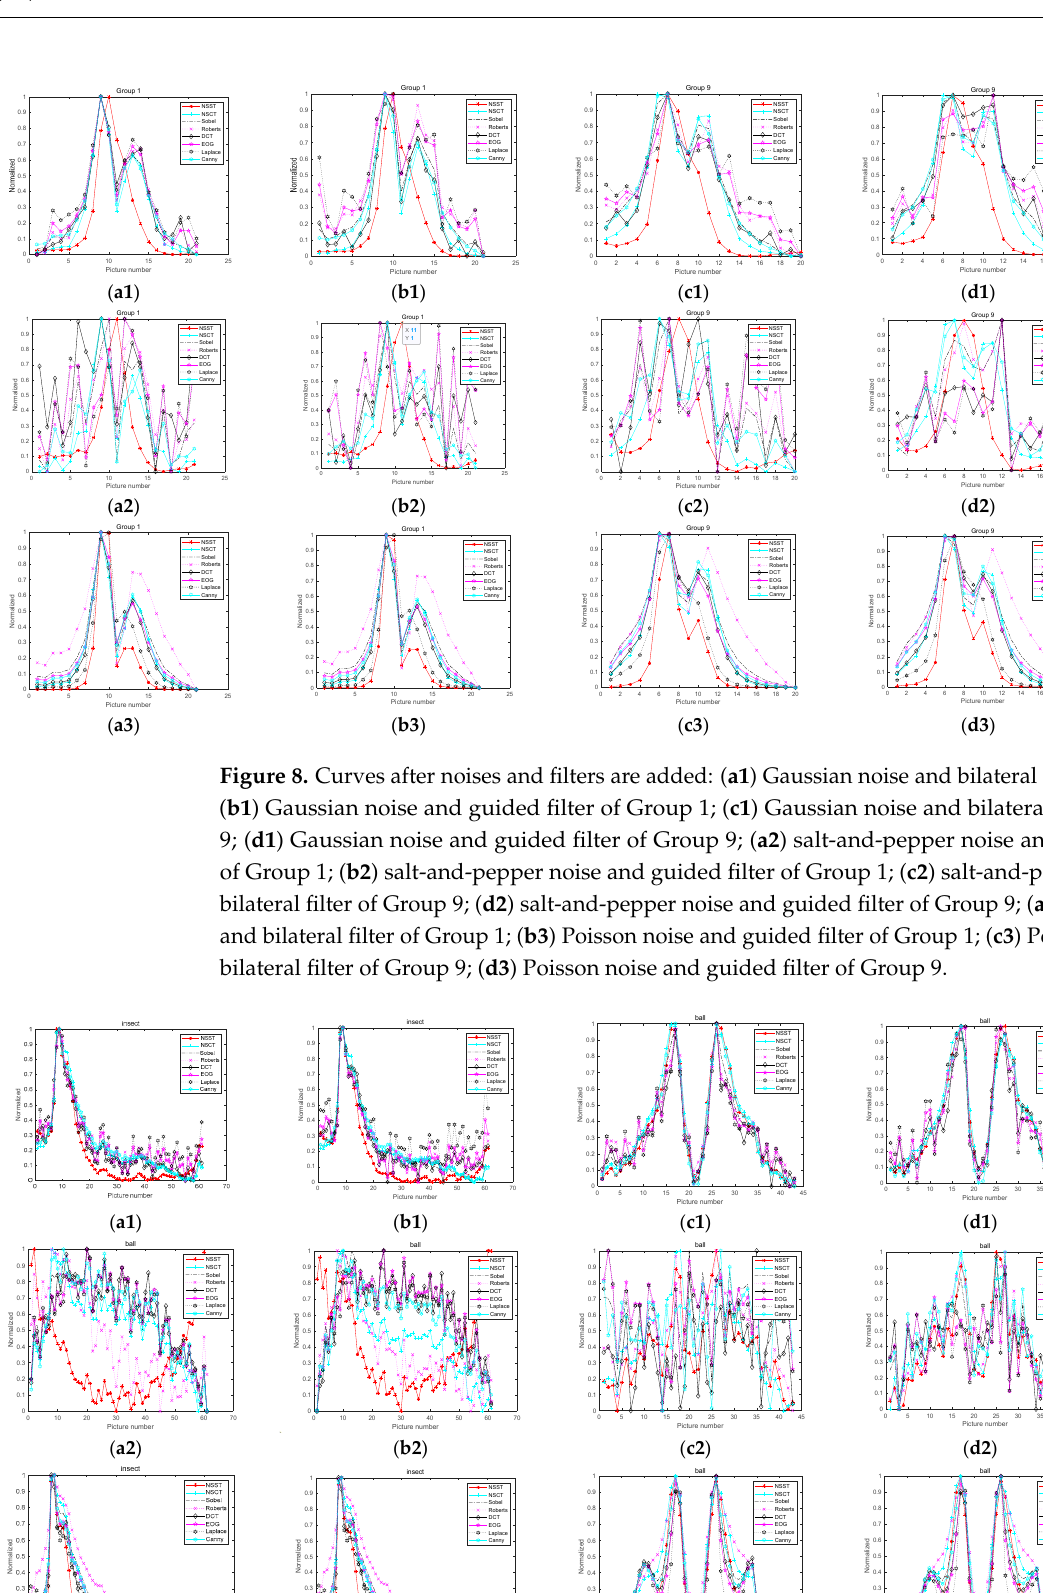
Figure 7. Image comparison: ( a1 , b1 , c1 , d1 ) are the datasets used in this study; ( a2 ) to ( d5 ) are two public datasets and two biomedical cell image sets; ( a1 , a2 , a3 , a4 , a5 ) clear cell image; ( b1 , b2 , b3 , b4 , b5 ) images with Gaussian noise added; ( c1 , c2 , c3 , c4 , c5 ) images with salt-and-pepper noise; ( d1 , d2 , d3 , d4 , d5 ) images with Poisson noise.